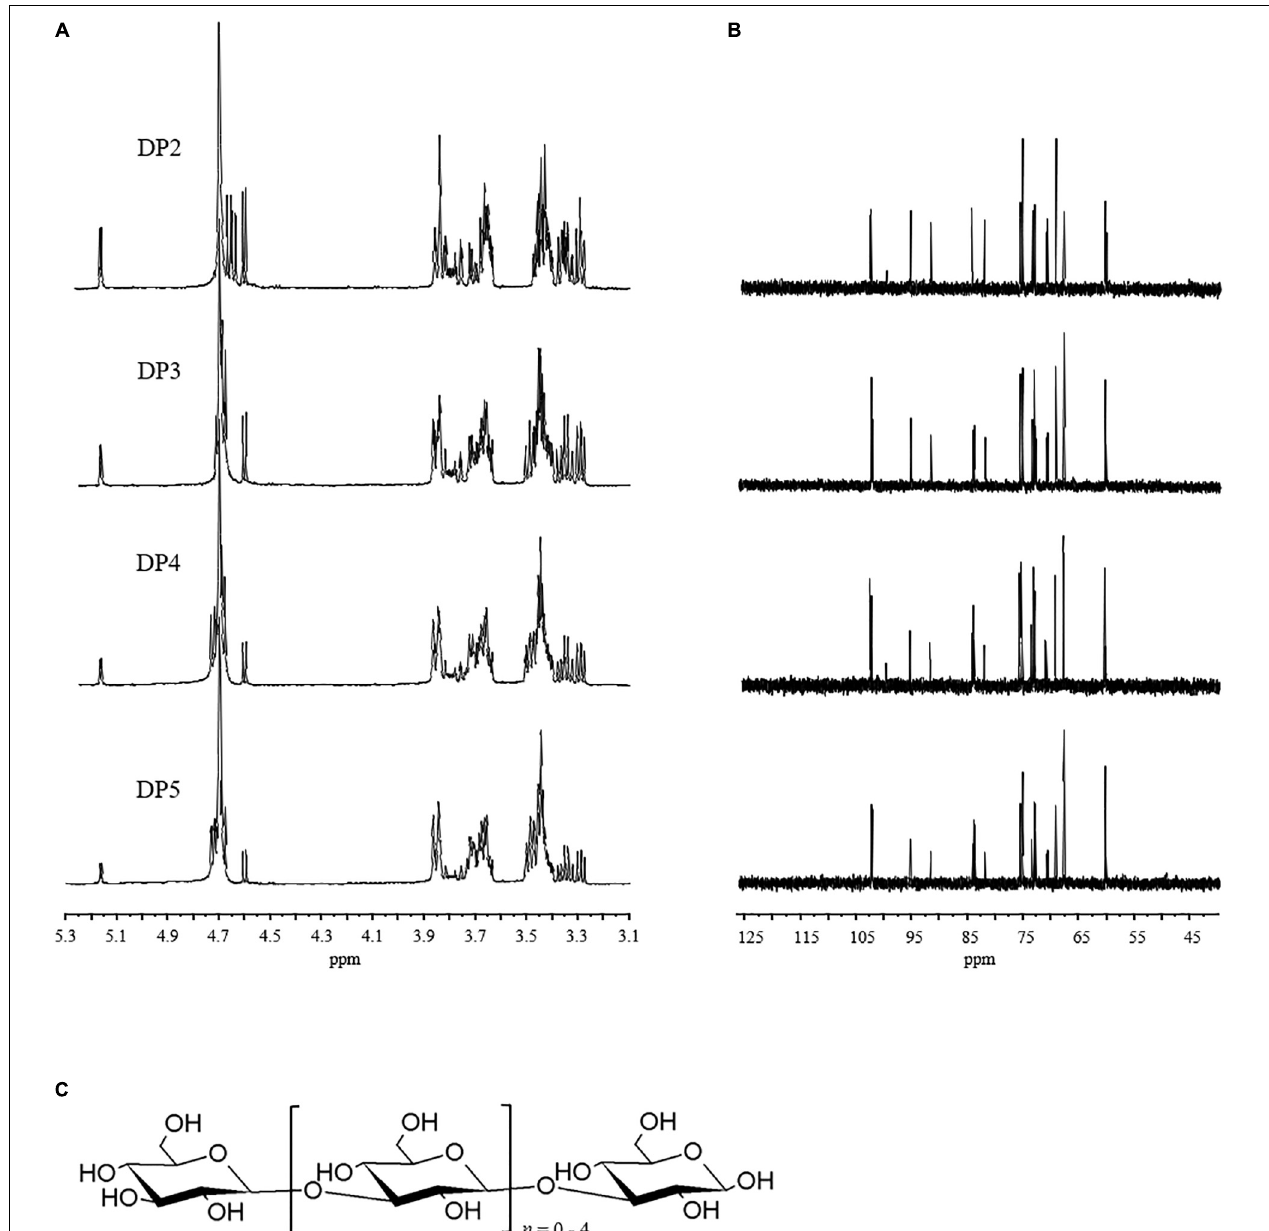
FIGURE 3 | (A) 1 H nuclear magnetic resonance (NMR) and (B) 13 C NMR of the purified LOs. (C) Proposed structure of LOs.